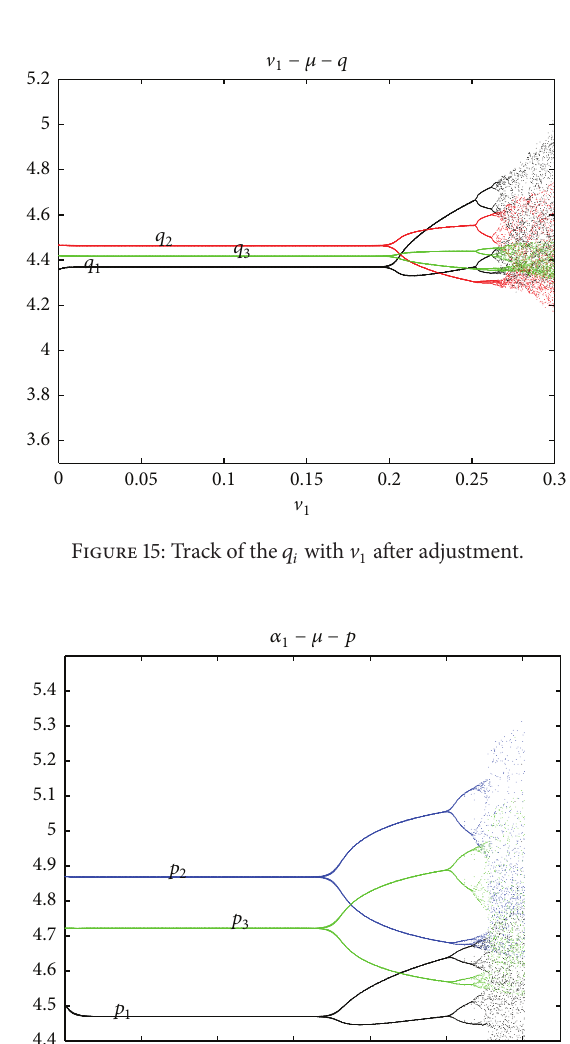
Figure 17: Track of the 𝑞 𝑖 with 𝛼 1 after adjustment.